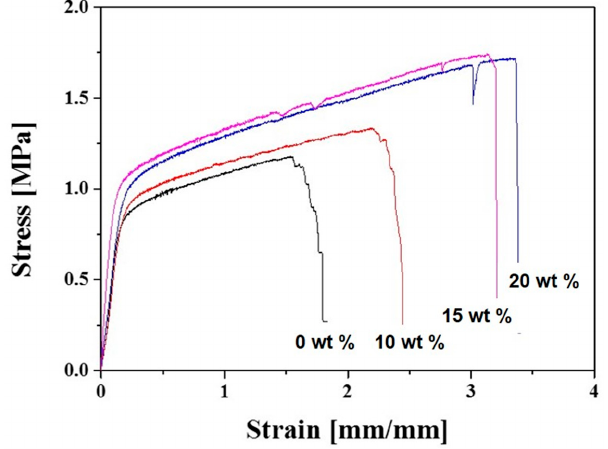
Figure 5. Representative stress versus strain responses of the macro/micro-porous PCL/HA composite scaffolds produced with various HA contents (0 wt %, 10 wt %, 15 wt %, and 20 wt %) under tension.